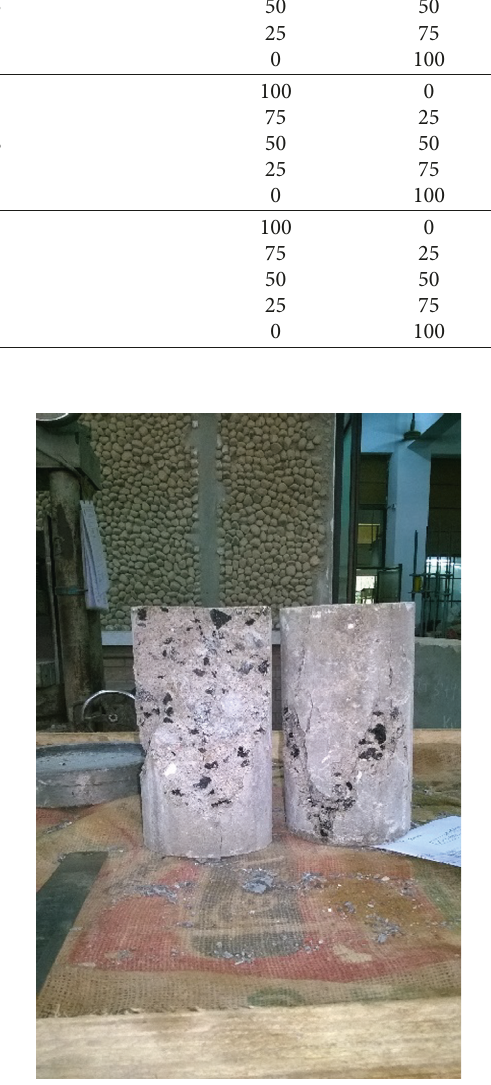
Figure 6: Failure surface of a recycled aggregate cylinder that contains IFS.